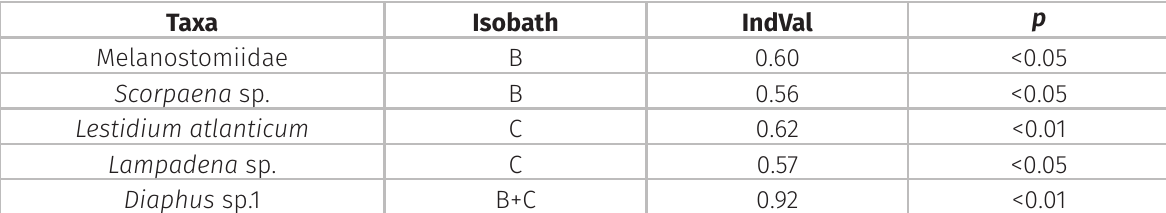
Table III. Ecological indicators of the continental slope area. IndVal – statistic value of the test; p – permutation p